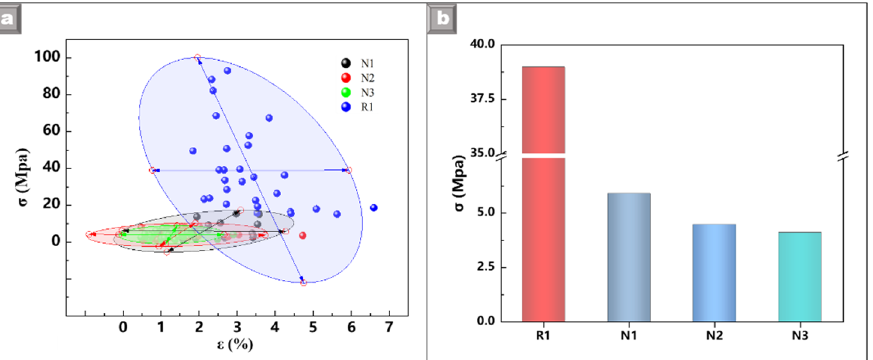
Figure 9. ( a ) Bending strength–failure strain and 95% confidence interval of archaeological wood; ( b ) Mean bending strengths of each group of samples.